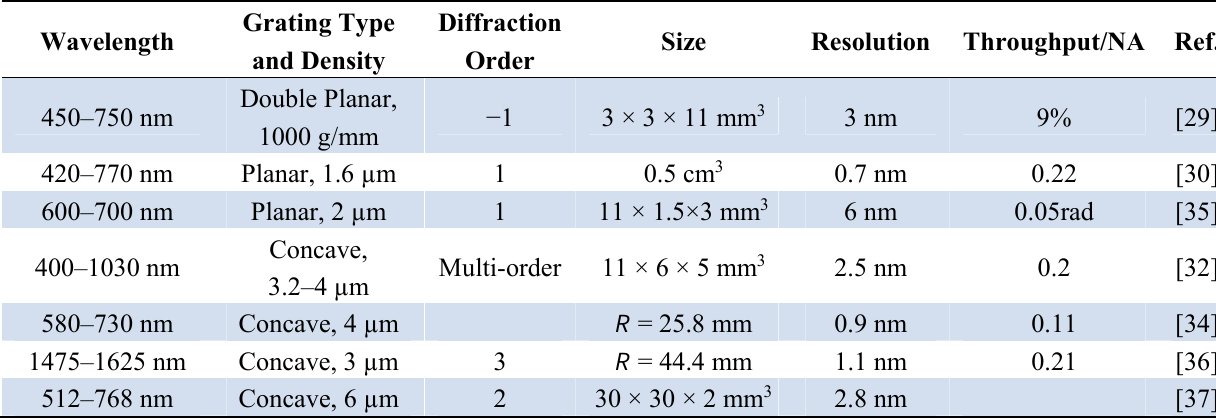
Table 4. Micro-spectrometers with nanometer spectral